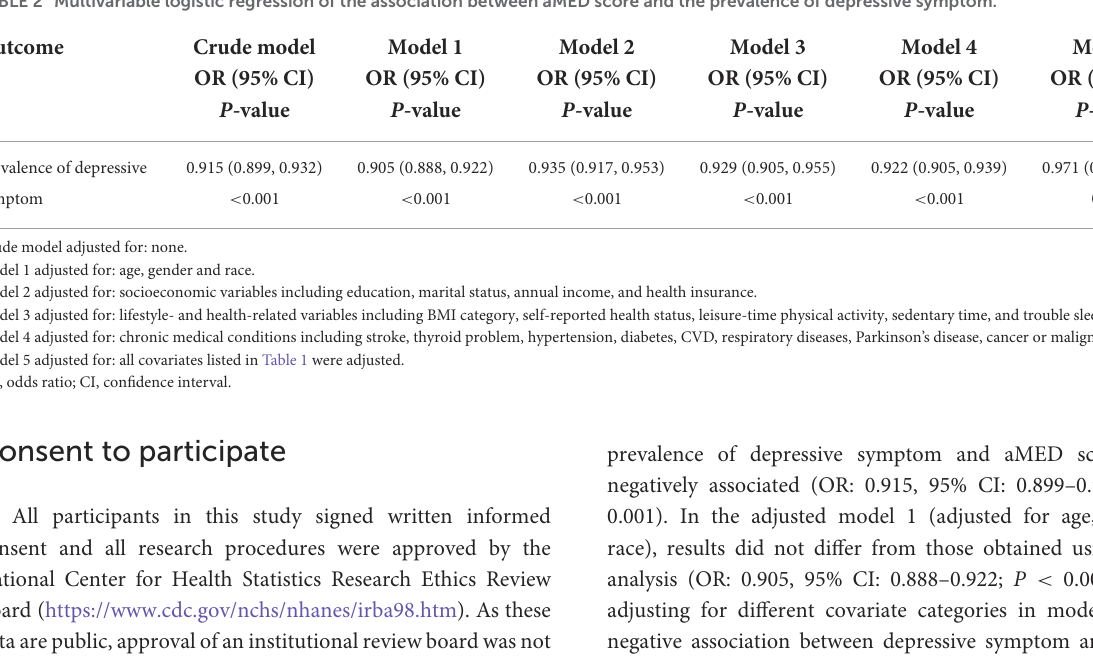
TABLE 2 Multivariable logistic regression of the association between aMED score and the prevalence of depressive